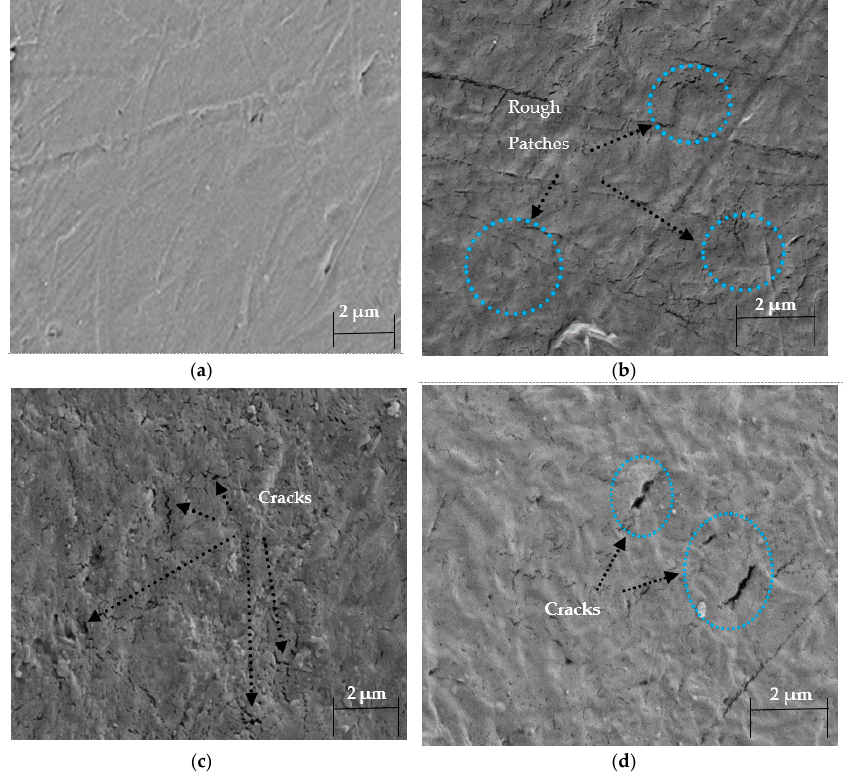
Figure 8. FESEM micrographs for virgin and aged samples . ( a ) Reference, ( b ) Experiment 1, ( c ) Experiment 2, ( d ) Experiment 3. The material loses its strength due to aging in the aggressive environment with an acidic gas (CO 2 ) under high temperature and pressure. Microcracks and surface damage were identified due to thermal degradation and the presence of chlorides in the autoclave chamber [44]. The appearance of roughness in experiment 1, while surface cracks in ex- periments 2 and 3 illustrate the attack of NaCl solution and CO 2 in the autoclave chamber under high temperature and pressure [69,70]. 3.5. Impedance Analysis EIS investigation was carried out to study the effect of CO 2 exposure and simulated seawater solution on virgin and aged HDPE samples. Figure 9 shows the corresponding Bode plot for virgin and aged samples.